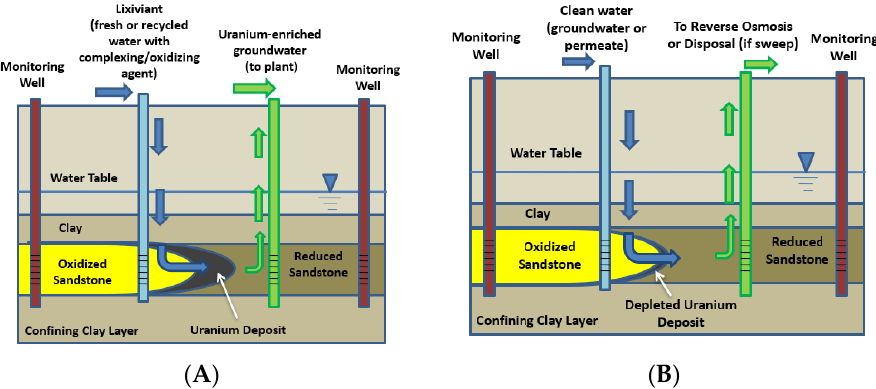
Figure 2. A conceptual model of the ( A ) production and ( B ) restoration phases of uranium ISR.